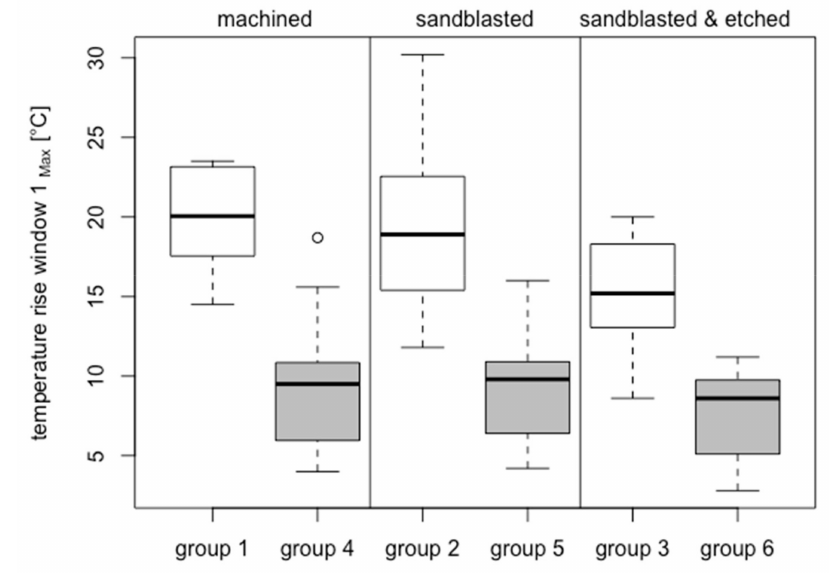
Figure 6. Box plots showing rise of temperature at bone window 1—results of all 6